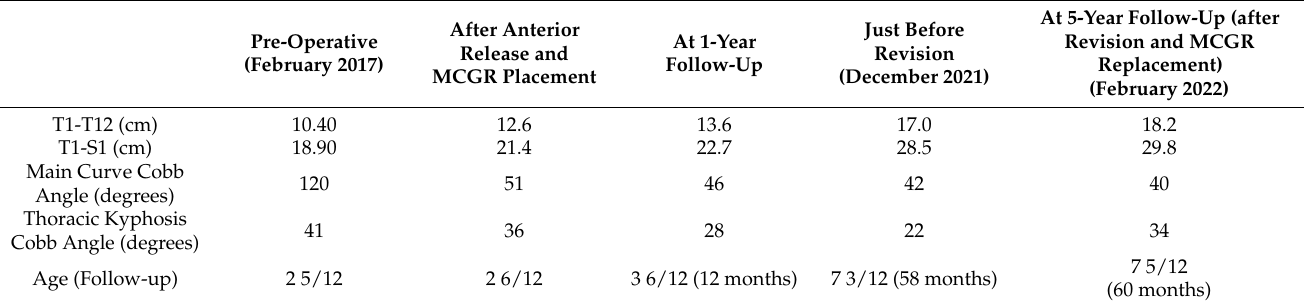
Table 1. Radiological parameters before and after surgical treatment.